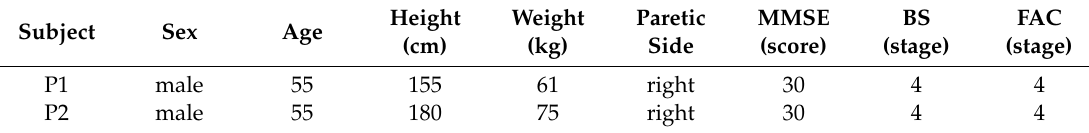
Table 2. Information of the stroke subjects.